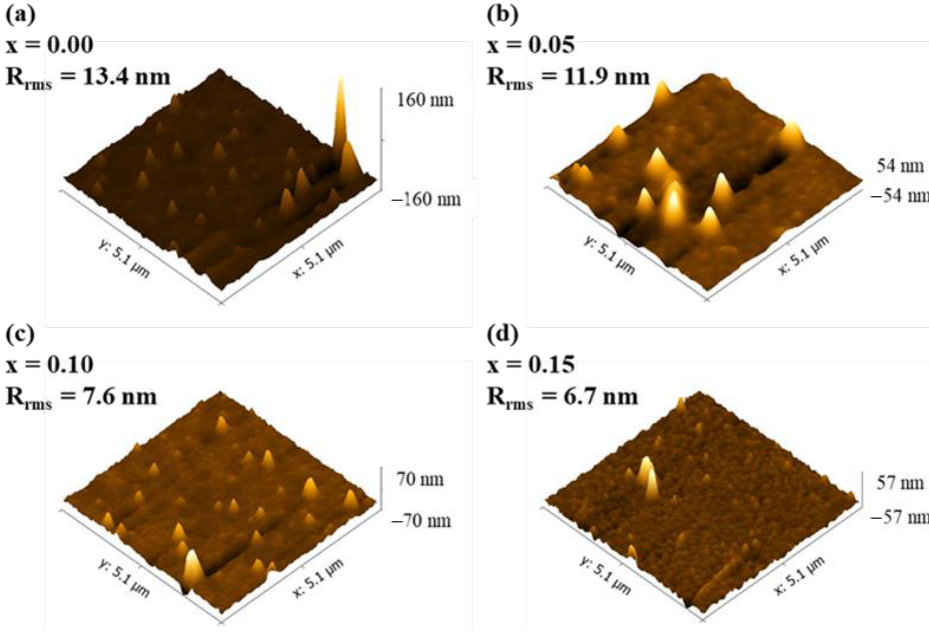
Figure 3. AFM images of Bi 1− x Gd x FeO 3 films: ( a ) x = 0.00, ( b ) 0.05, ( c ) 0.10, and ( d ) 0.15. For Bi 1 − x Gd x FeO 3 films with x = 0.00, 0.05, 0.10, and 0.15 films, polarization